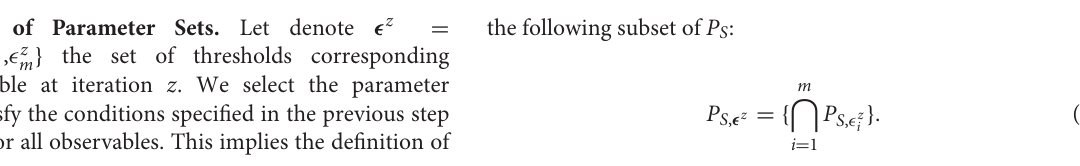
4. Intersection of Parameter Sets. Let denote ǫ